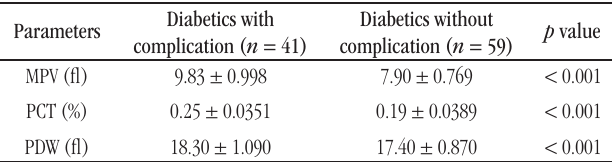
taBLE 4 – Platelet parameters in diabetic individuals with and without chronic complications Diabetics Parameters